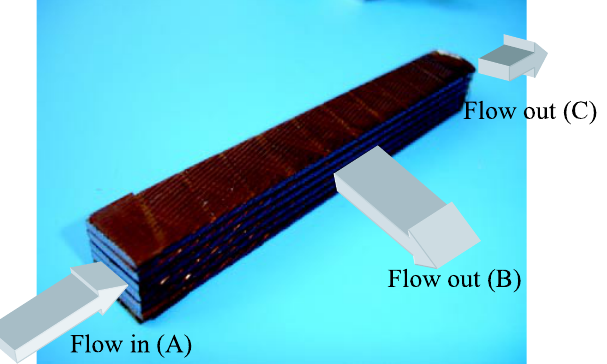
MPa.FIG. 11. (Color) Cured stack of insulated cables with radial flow path shown: air enters longitudinally and exits laterally after having crossed insulation wraps.